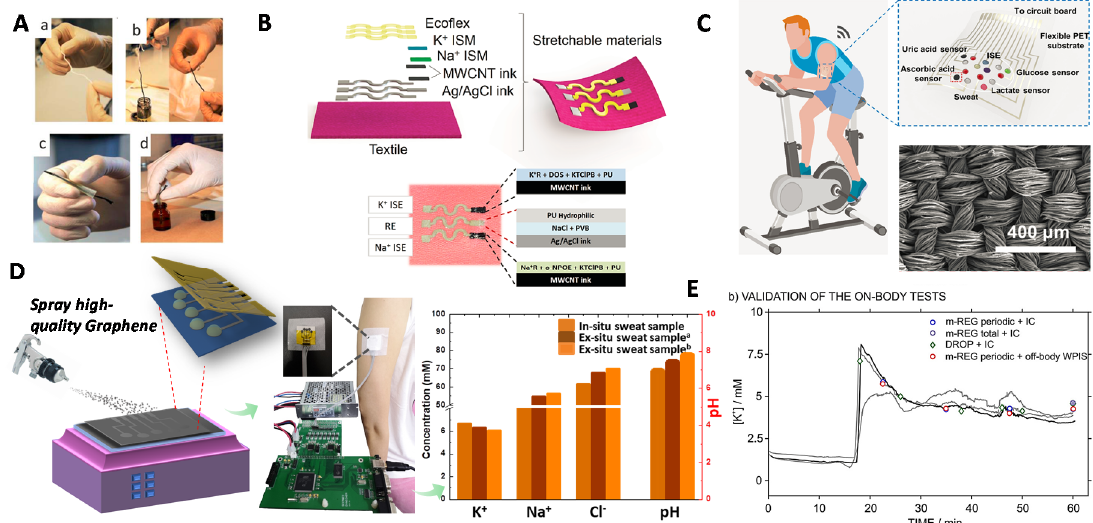
Figure 9. Carbon-based wearable SC-ISEs for skin sweat ion sensing. ( A ) SWCNT-based flexible SC-ISEs by using cotton yard as flexible substrate. Reprinted with permission from [78], Copyright (2013) Royal Society of Chemistry. A series of preparation including SWCNT ink and ISM dipping as shown in ( a – d ). ( B ) Multi-wall carbon nanotube (MWCNT) textile-based SC-ISEs for Na + and K + sensing. Reprinted with permission from [80], Copyright (2016) John Wiley and Sons publications. ( C ) Carbon textile-based sensor array for multiparameter analysis. Reprinted with permission from Science Advances [81], Copyright (2019) American Association for the Advancement of Science. ( D ) High- quality graphene-based wearable SC-ISEs for multichannel ion sensing including K + , Na + , Cl − and pH [82]. ( E ) The suggested protocol for on-body measurement. It should be noted that the importance of calibration of SC-ISEs to assure the accuracy of real-time analysis. Reprinted with permission from [83], Copyright (2019) American Chemical Society.